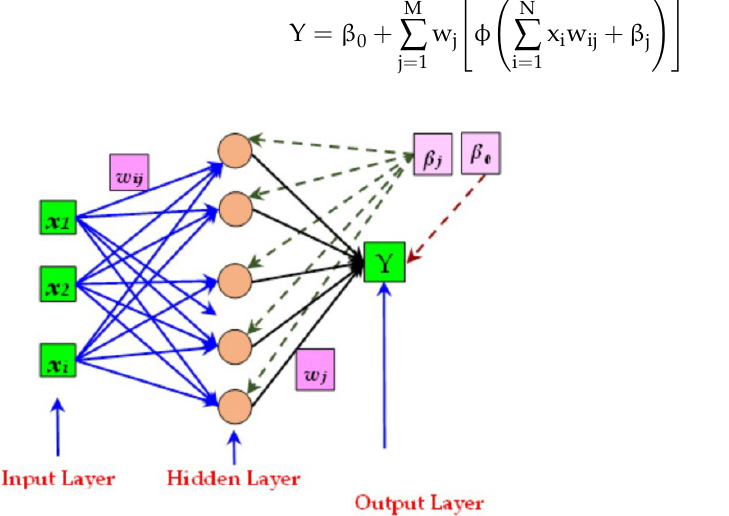
Figure 3. MLPNN model structure with N input, M hidden and 1 output neurons [74].